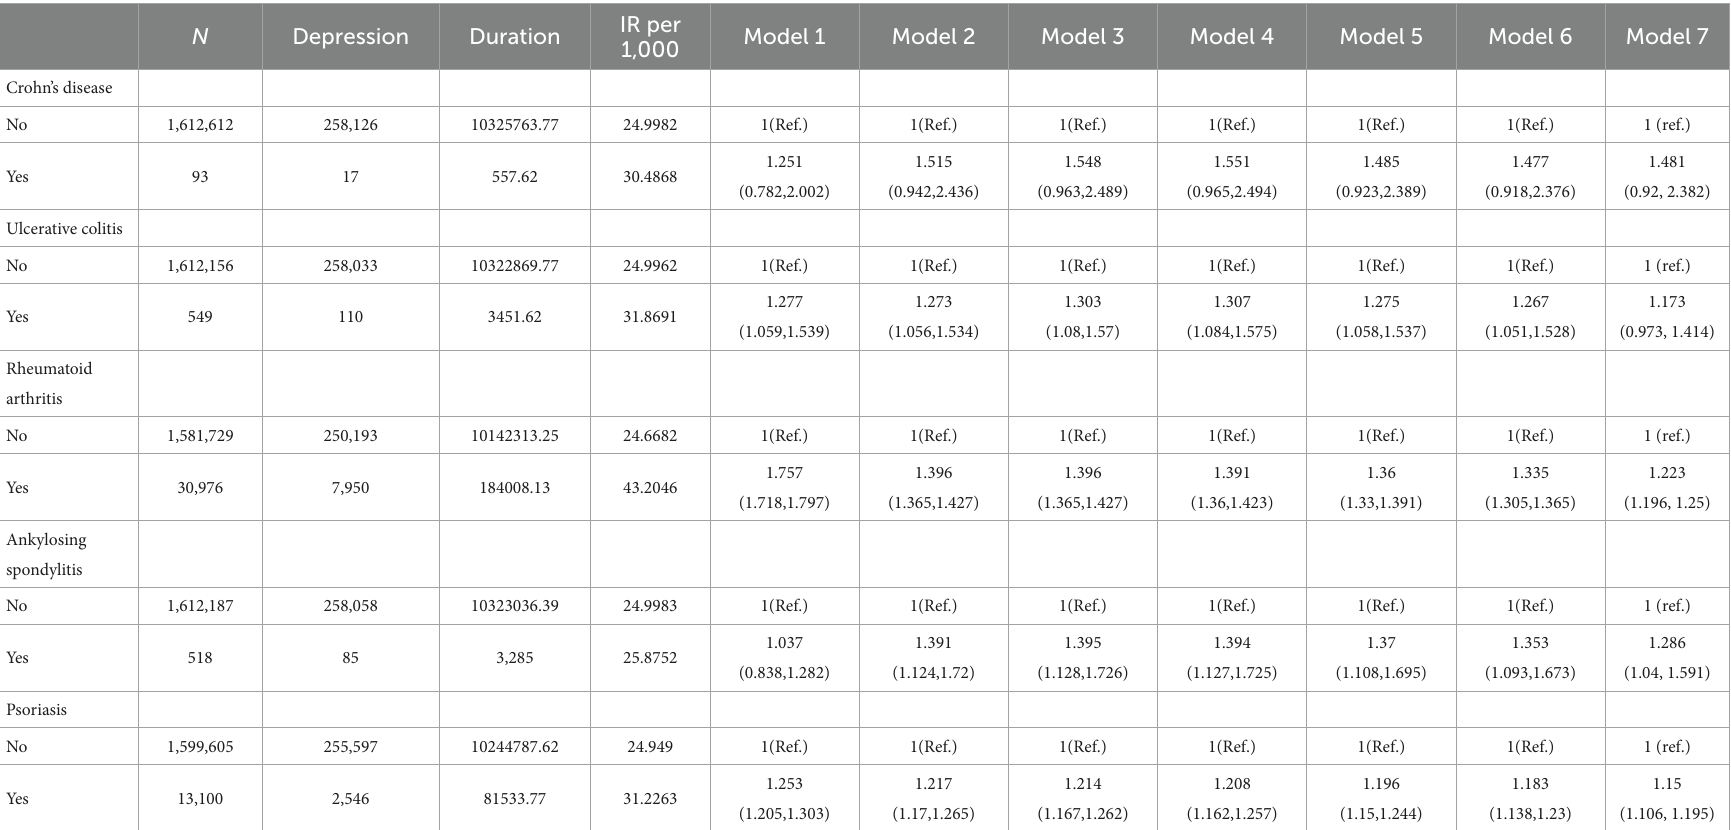
TABLE 3 Risk of depression according to the presence of individual immune-mediated inflammatory